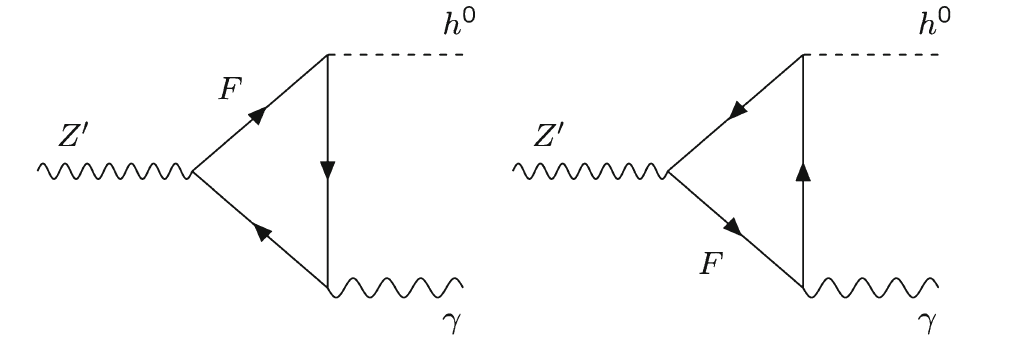
Fig. 2 One-loop contributions of a fermion F to the Z (cid:2) → h 0 γ amplitude